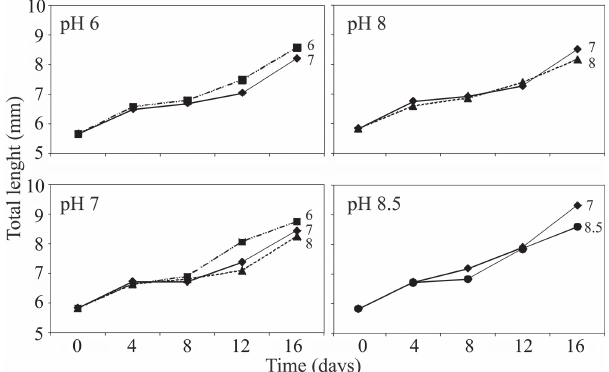
Fig. 2. Growth curves in total length of the Prochilodus lineatus larvae after 16 days of larviculture. The results are grouped in the different pH values used in the